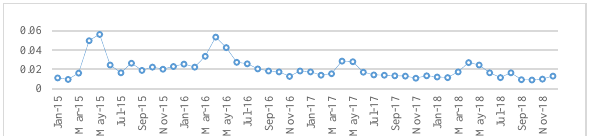
Figure 6. Tourism Percentage in Aguinid Falls, Samboan, Cebu from 2015 to